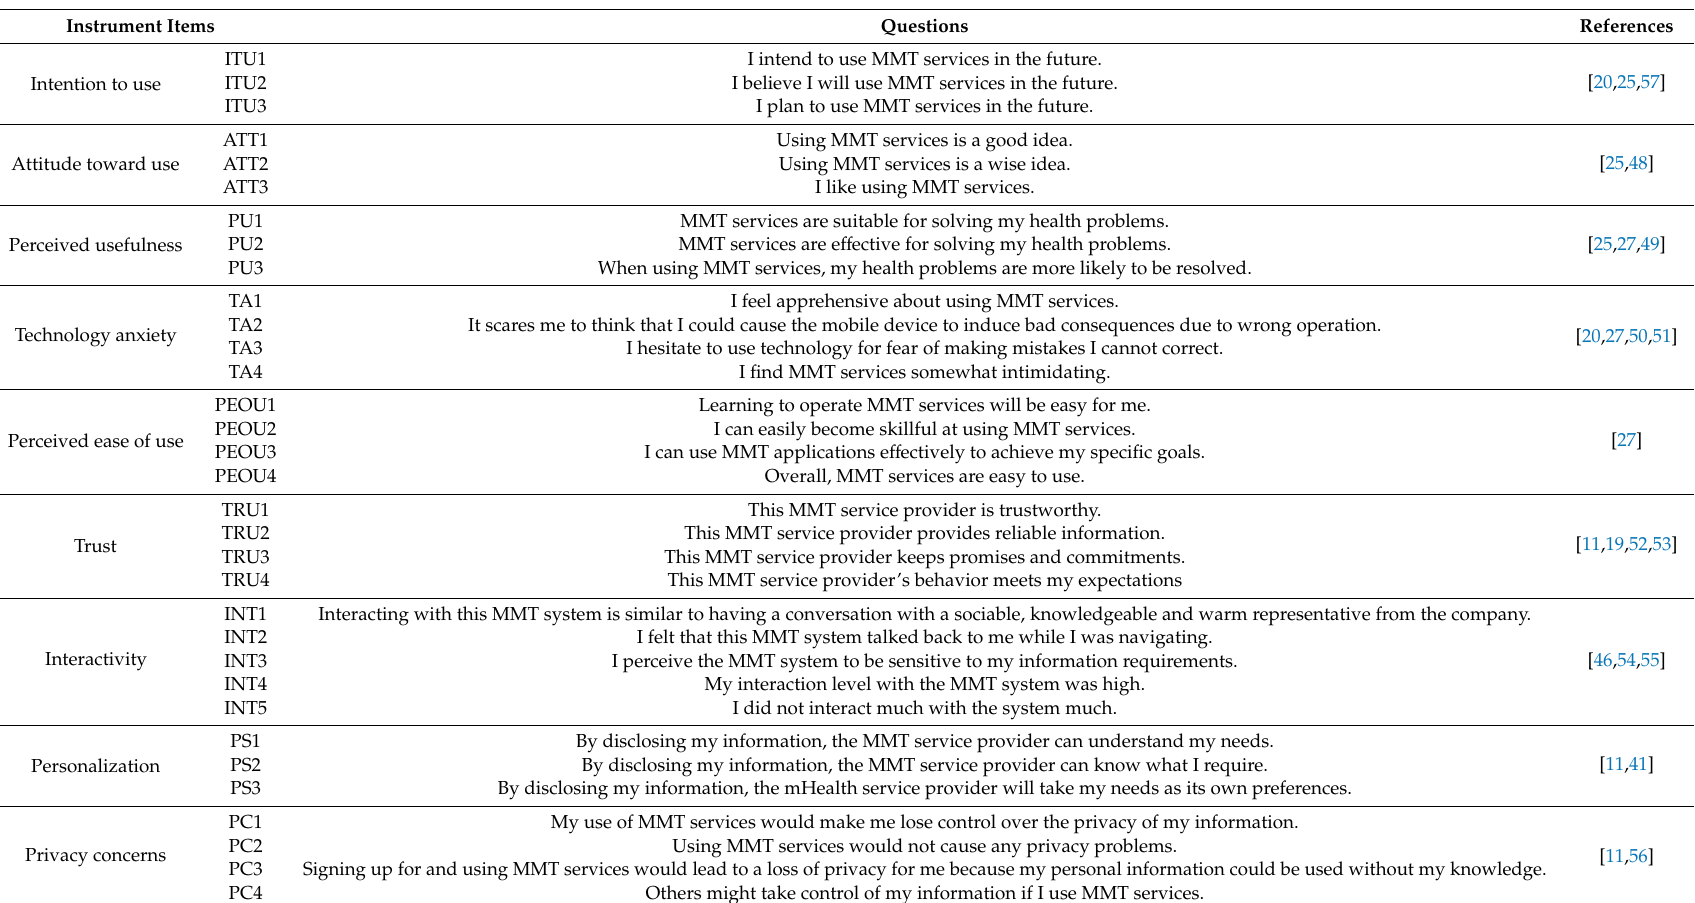
Table 1. Construct items of the